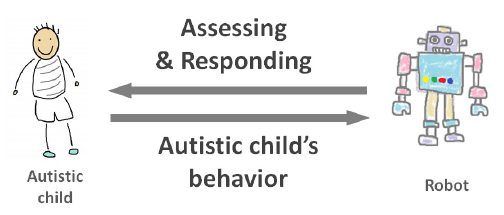
Fig. 1. The interaction concept in robot-assisted autism